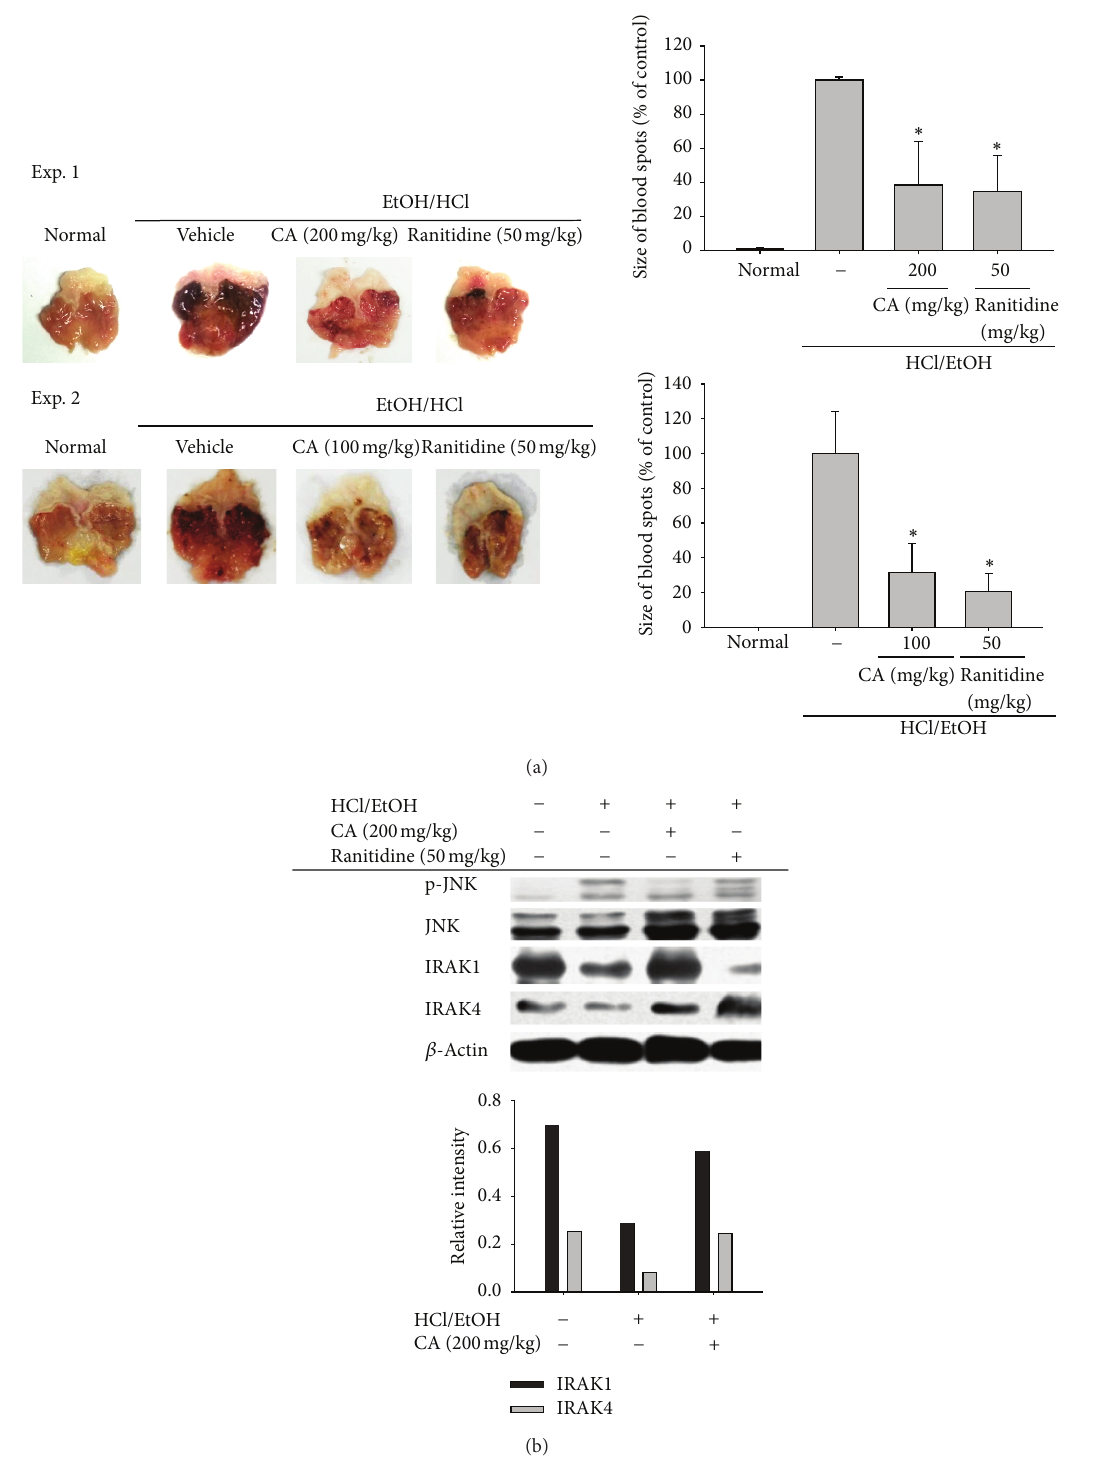
Figure 5: Effect of CA on inflammatory lesions in HCl/EtOH-treated stomachs in mice. (a) Mice orally administered either 200 mg/kg ((a) upper panel) or 100mg/kg ((a) lower panel) or ranitidine (50 mg/kg) for 2 days were orally treated with HCl/EtOH. After 1 h, gastric lesions (the area (mm 2 )) in the stomach were measured with a pixel-counter; representative photos are shown. The gastritis index of the control group (inducer alone) was set to 100%. (b) Phosphoprotein or total protein levels of JNK, IRAK1, and IRAK4 in stomach lysates were determined by phosphospecific or total protein antibodies. Relative intensity was calculated using total levels by the DNR Bioimaging system. ∗ 𝑃 < 0.05 , compared to